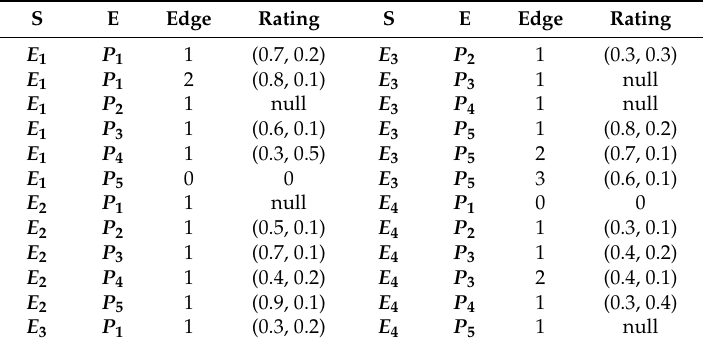
Figure 1. An example of a reputation-propagated supply chain network. Table 1. The raw rating matrix M 1